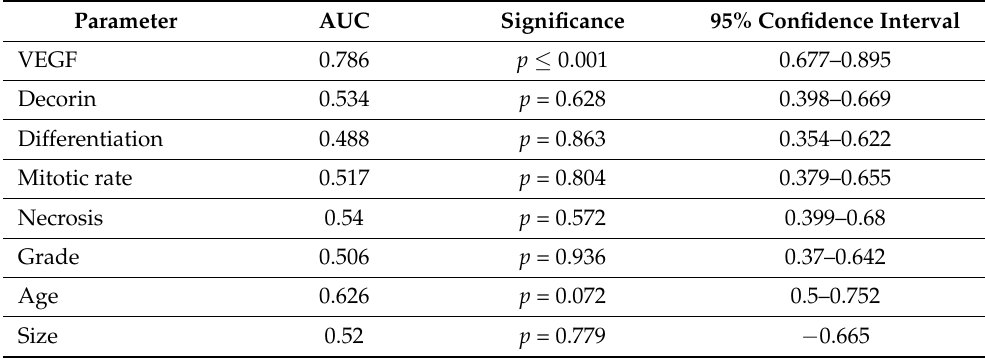
Table 3. AUC of ROC curve for individual parameters in the IHC